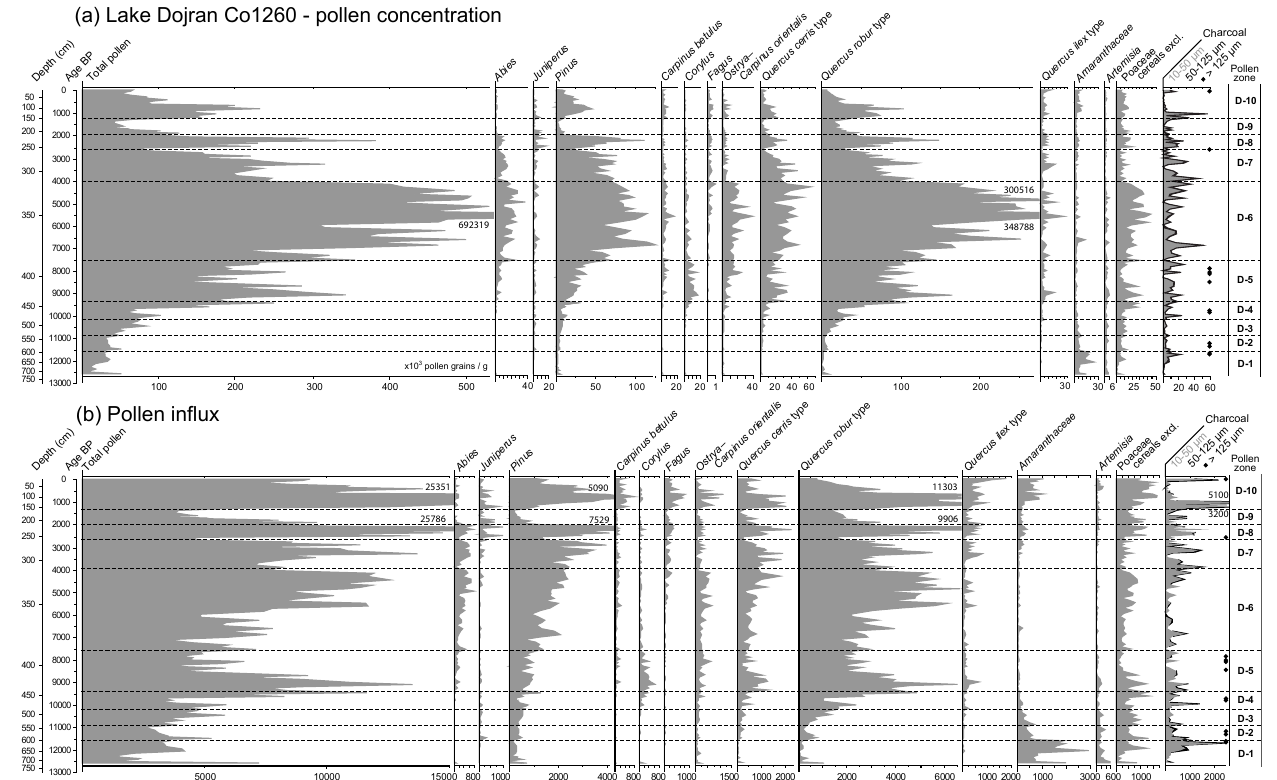
Figure 3. Concentration (a) and influx (b) pollen diagrams of selected taxa and charcoals.